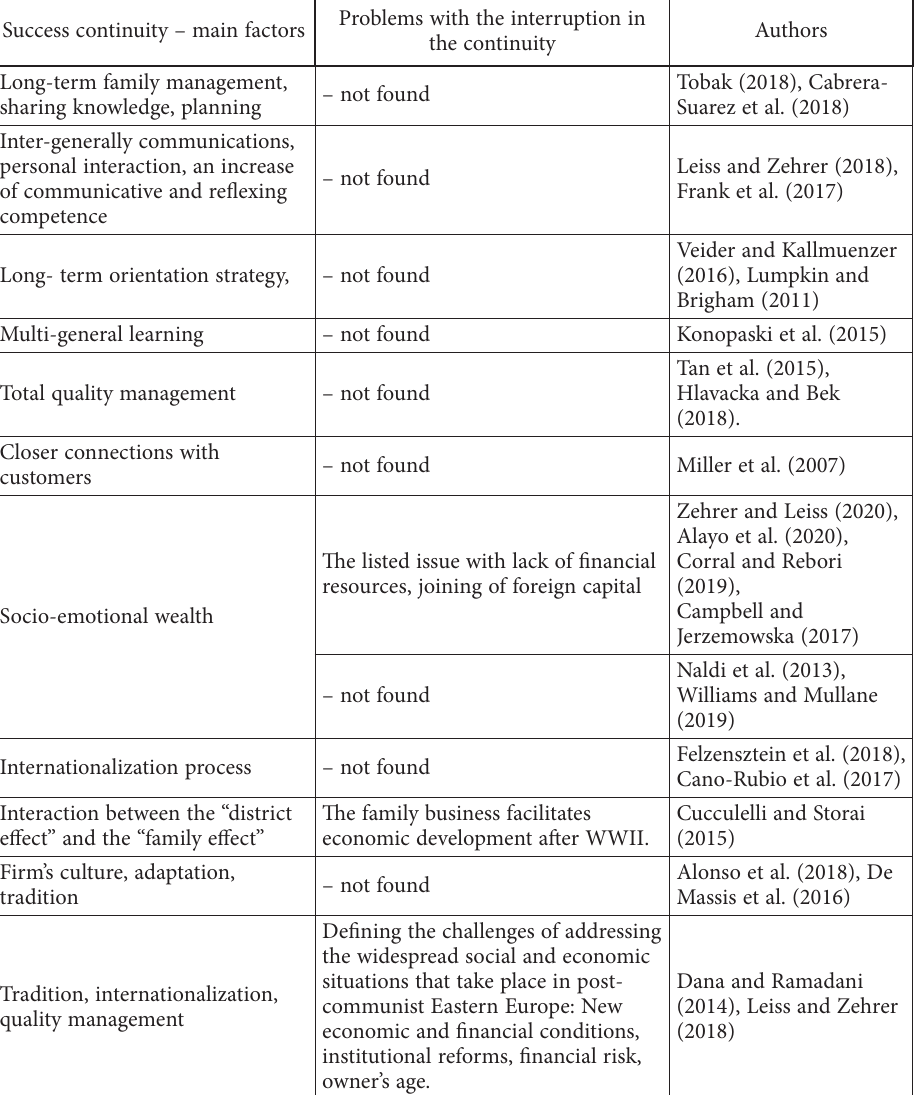
Table 1. Problems of interruption in family business continuity in